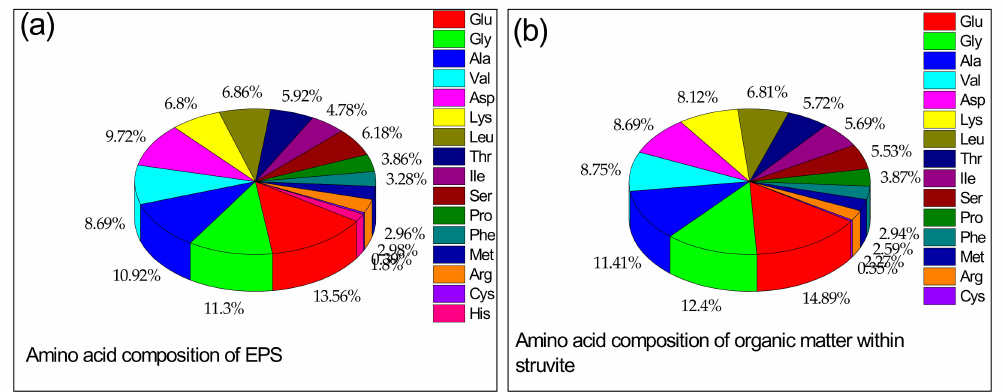
Figure 8. Amino acid composition of EPS ( a ) and amino acid composition of organic matter within struvite at Mg / Ca ratio of 12 ( b